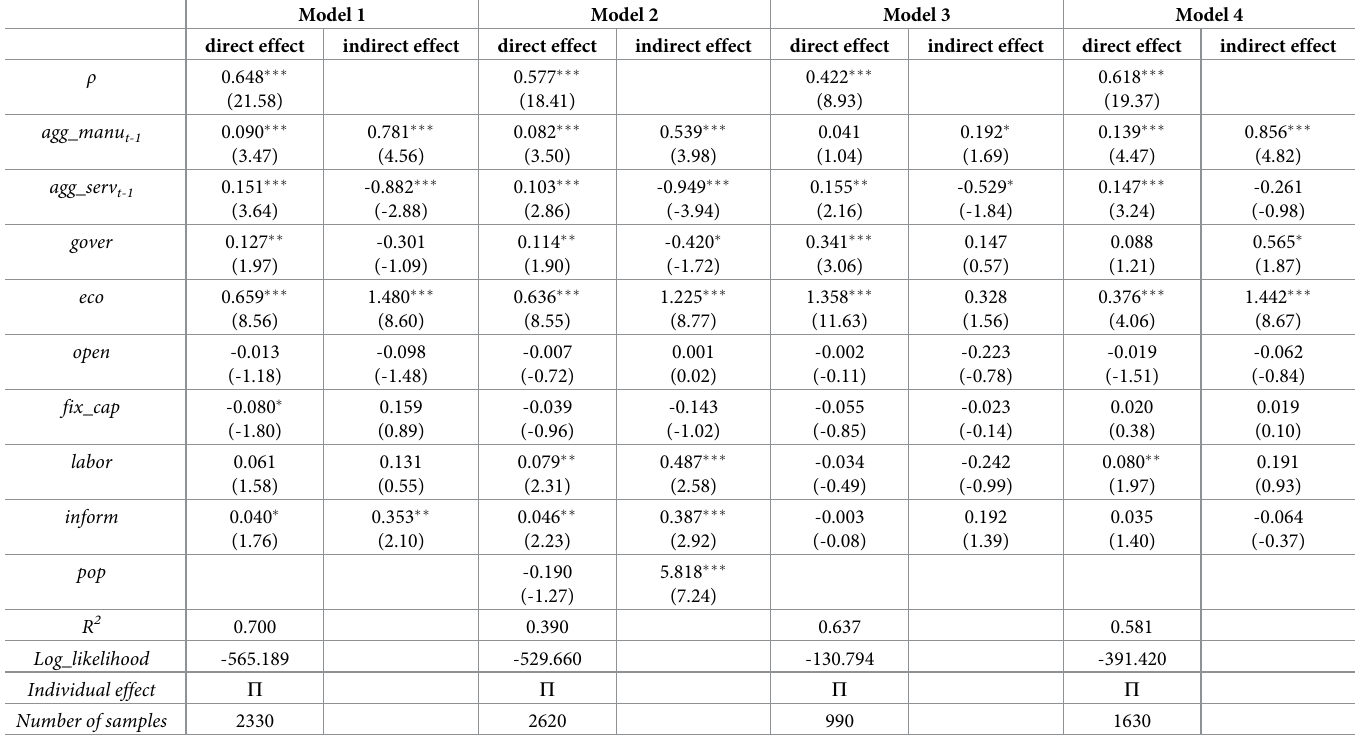
Table 7. Robustness check based on geographic weight